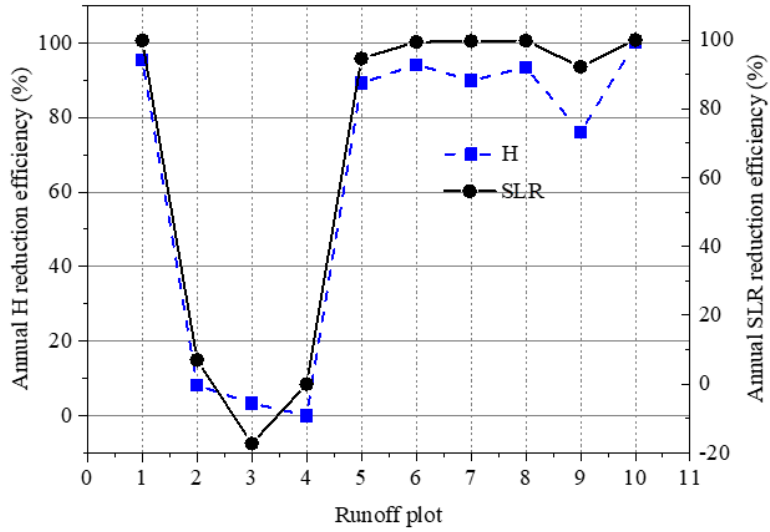
Figure 3. Reduction efficiencies of annual runoff depth (H) and annual soil loss rate (SLR) in 2014–